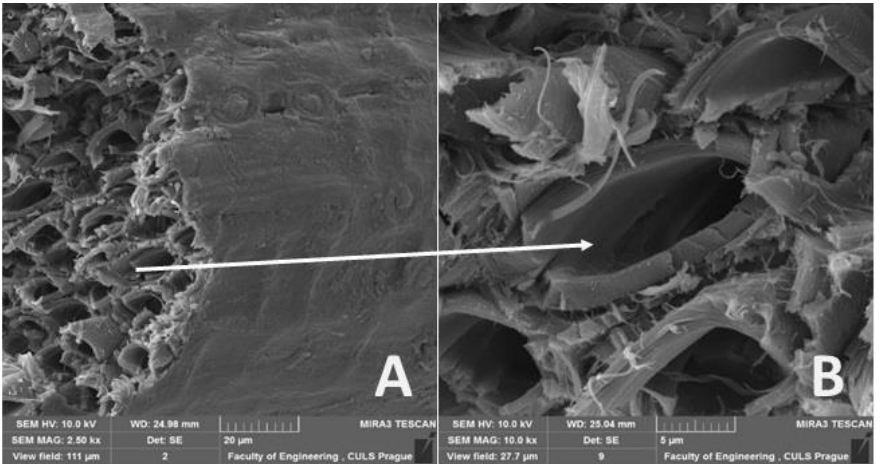
Figure 1. SEM images of cut through coir ( A ): Overall view of fibers (MAG 2.50 kx) ( B ): Detailed view of the fiber cut, with a polygonal shape (MAG 10.00 kx).